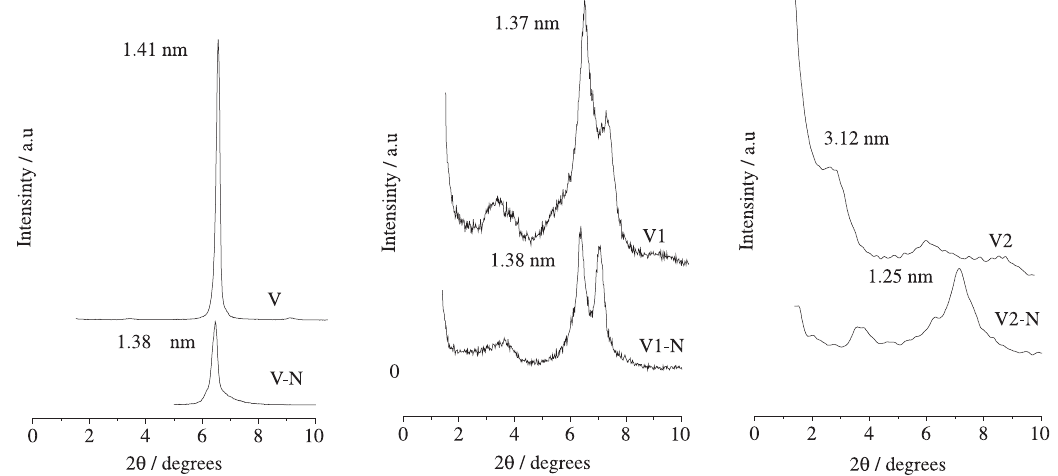
Figure 3. XRD patterns of the host matrices V and V-N, V1, V1-N, V2 and V2-N synthesized